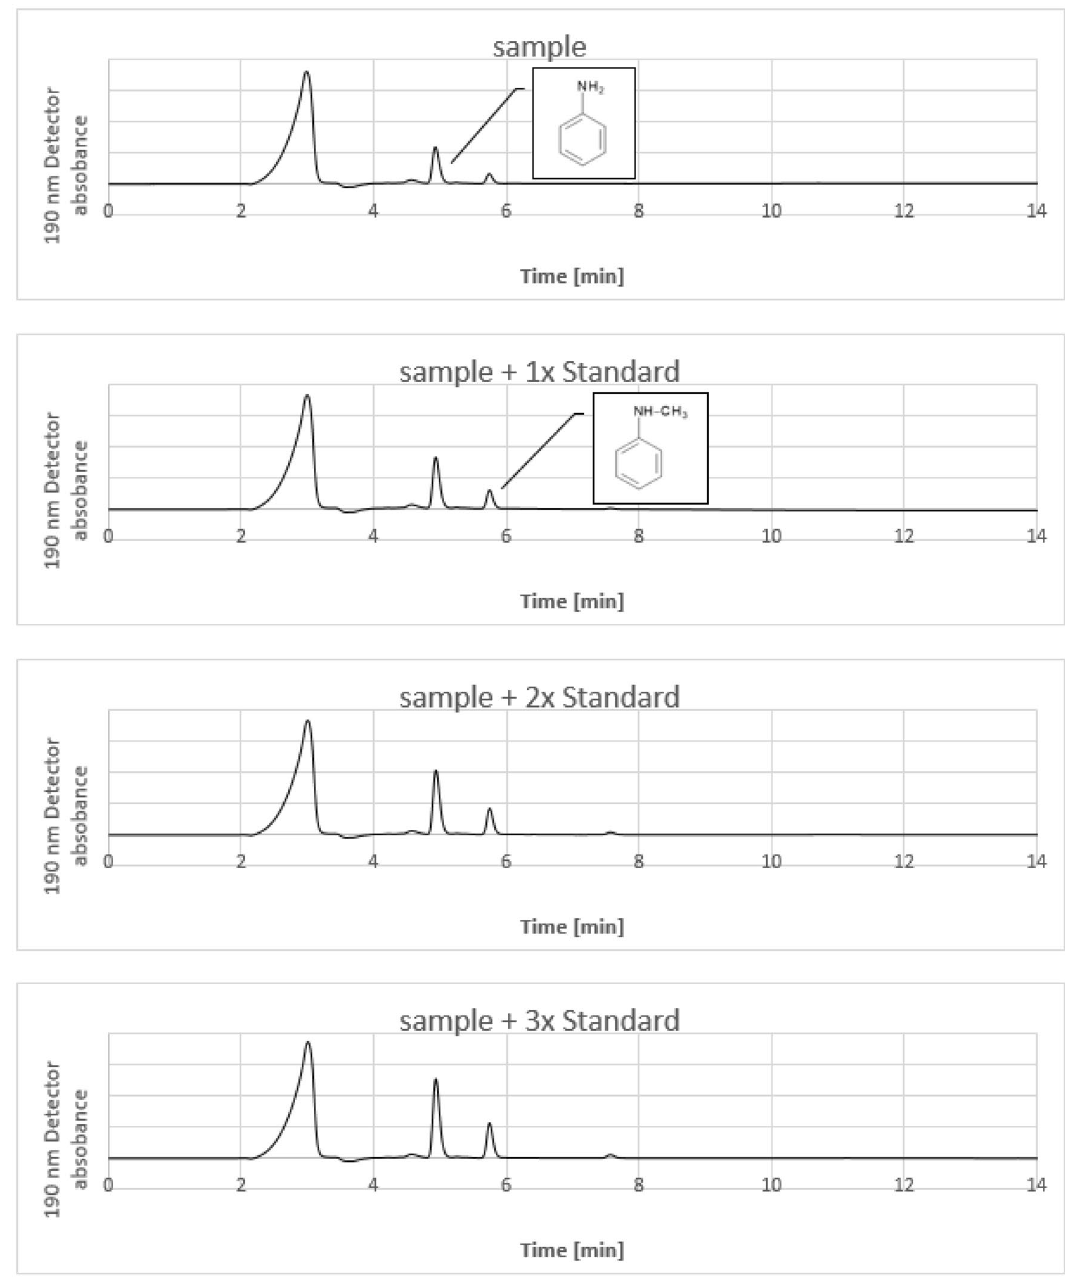
Figure 4. HPLC chromatograms of the acidic indigo extraction without and with the addition of standard. The peak at 4.94 min corresponds to aniline and the peak at 5.76 min corresponds to